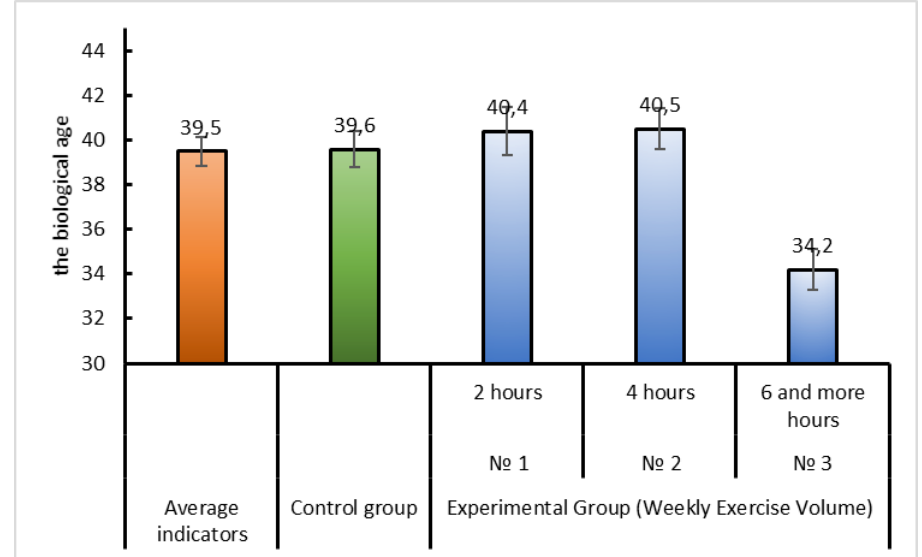
Fig. 2. The dependence of indicators of biological age of the girls of 1 st year on weekly volume of physical activities during the school year